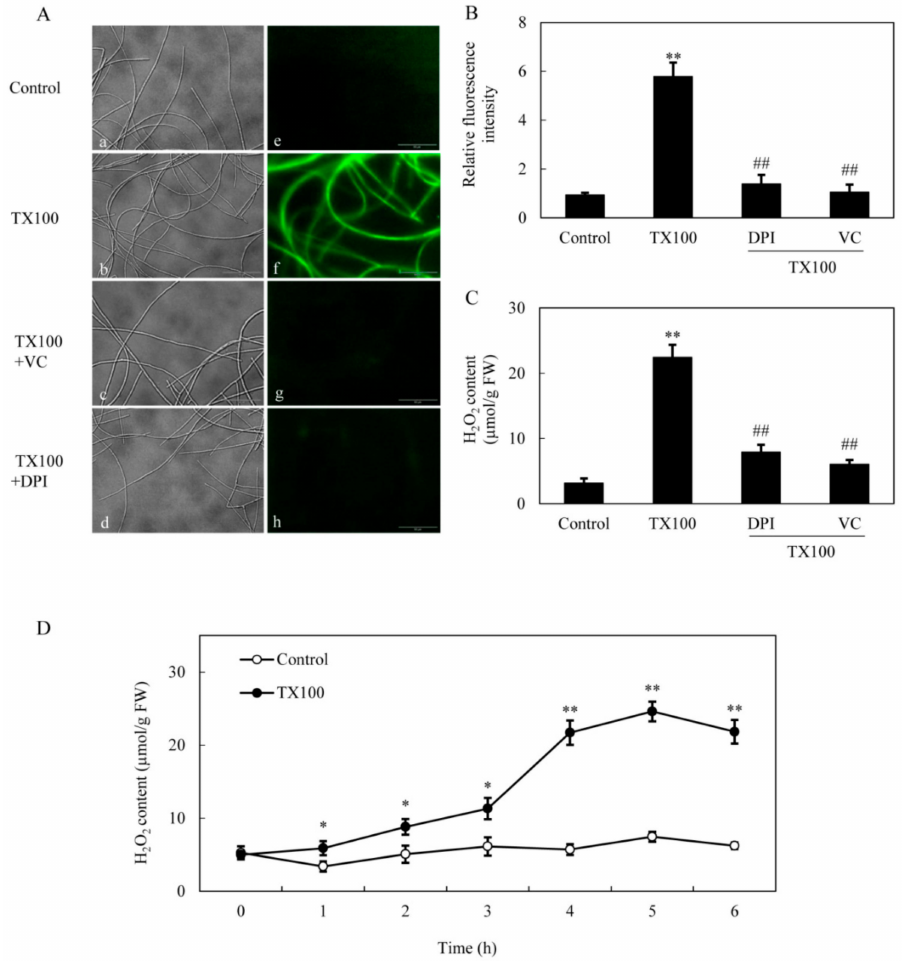
Figure 4. ROS generation in the extractive fermentation. ( A ) Bright-field image (left) and fluorescence microscopy of DCFH-DA-stained mycelium (right) in cultures. TX100 was added at 25 g / L at 36 h of the fermentation. DPI (5 µ M) or VC (10 µ M) was added 30 min prior to TX100 treatment respectively. The photo was taken after 5 h of TX100 treatment. ROS accumulation (relative fluorescence intensity) ( B ) and H 2 O 2 content ( C ) in mycelium after TX100 treatment. ( D ) Time-course of H 2 O 2 contents in mycelium after TX100 treatment. Values are mean ± SD from three independent experiments ( ** p < 0.01 vs. control, ## p < 0.01 vs. TX100